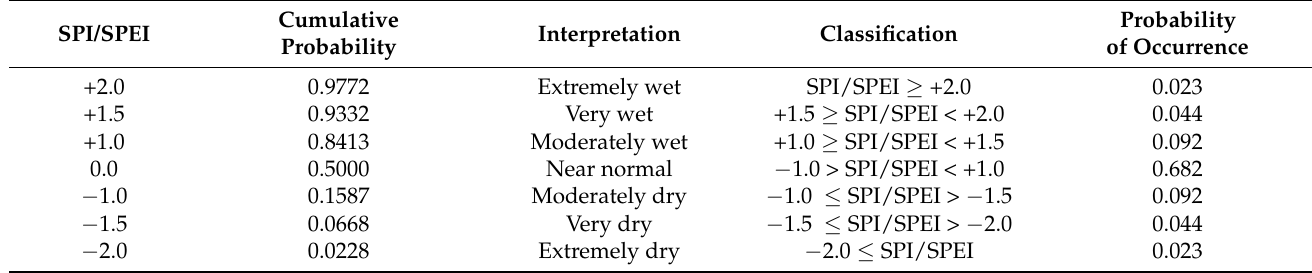
Table 2. SPI- and SPEI-based classification for the various drought categories.